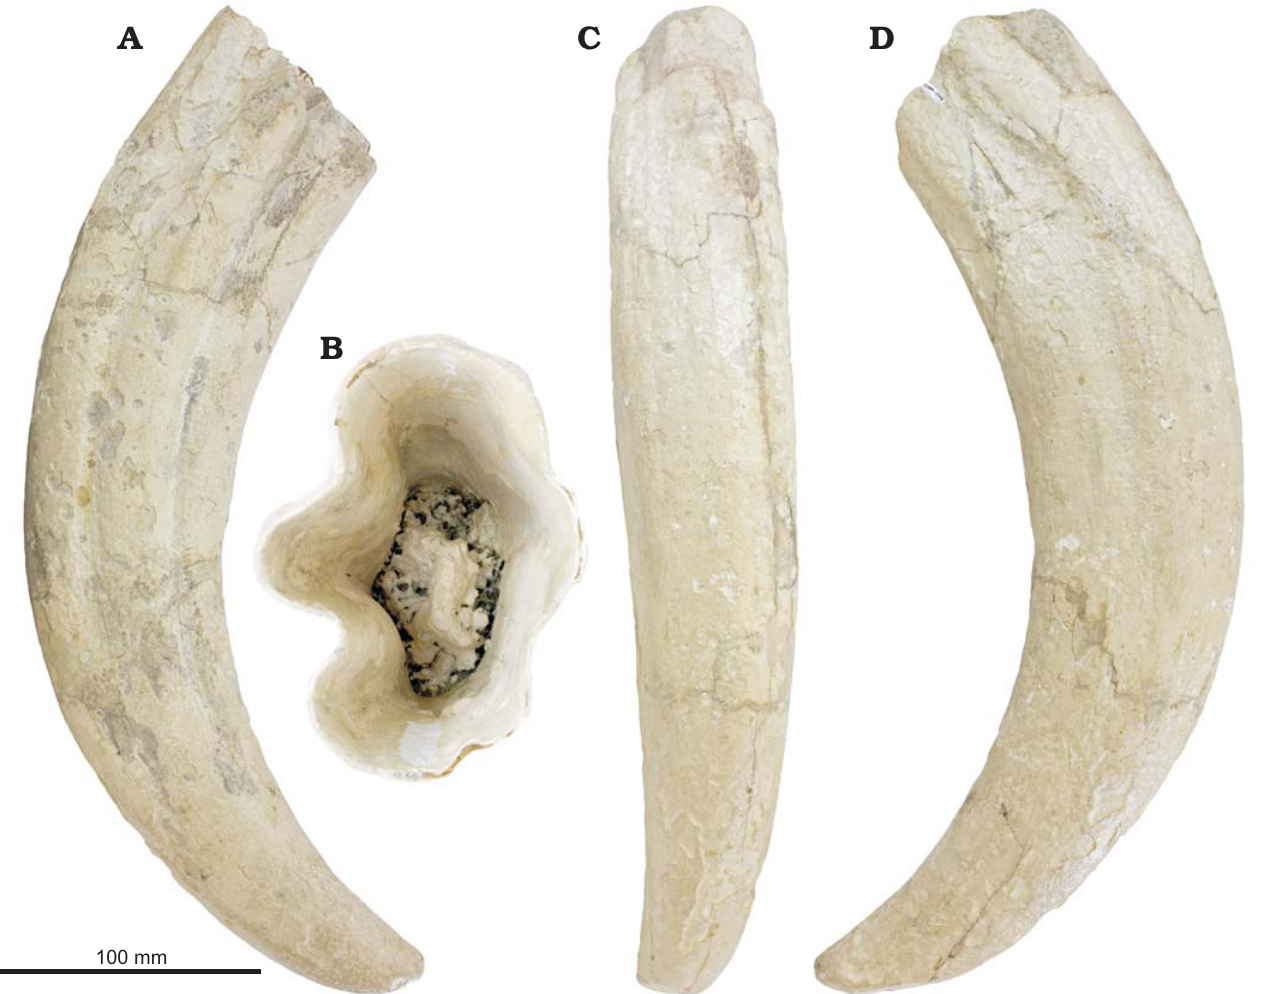
Fig. 2. Right canine tusk of odobenid walrus Ontocetus emmonsi (CCNHM 1144) from the Lower Pleistocene ?Waccamaw Formation, Austin Sand Pit, South Carolina, in lingual ( A ), proximal ( B ), anterior ( C ), and labial ( D ) views.